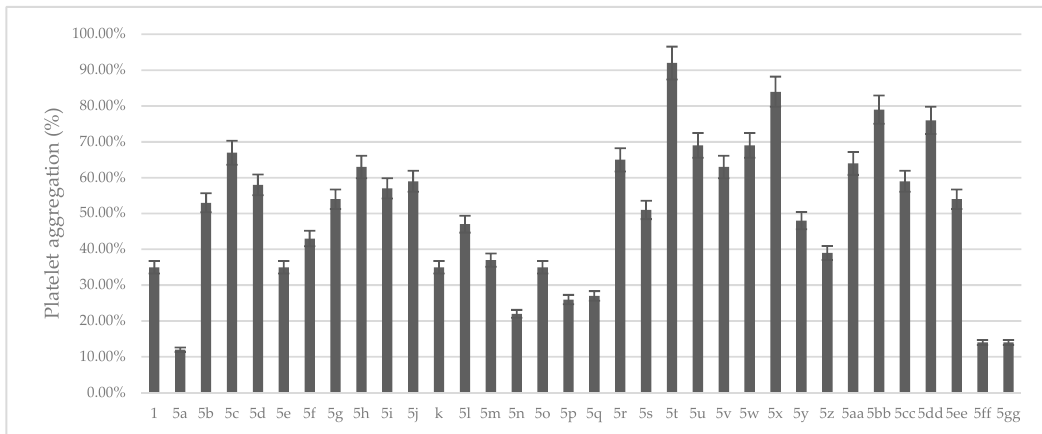
Figure 3. Antiplatelet aggregation activities of the 10-substituted 1,2,3-triazole-ginkgolide B derivatives. Ginkgolide B ( 1 ) was used as reference.